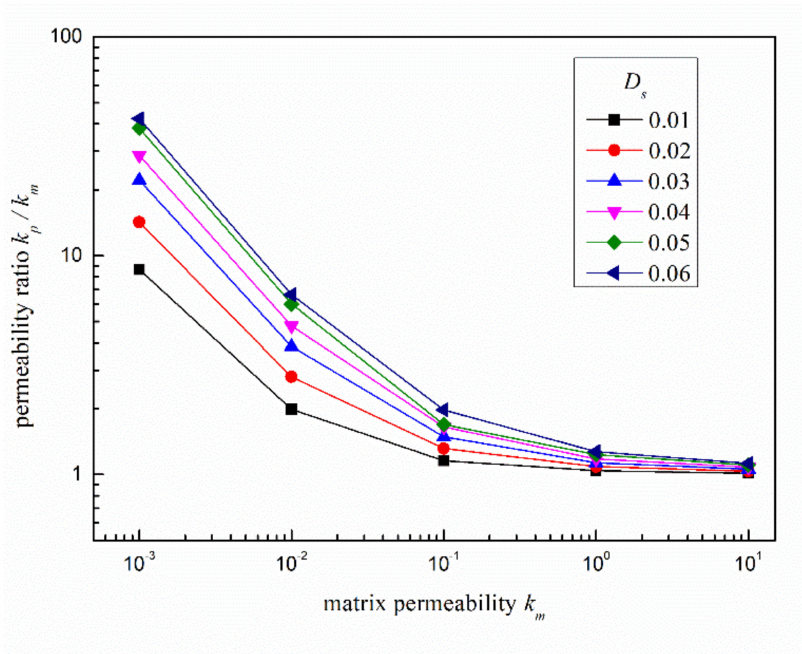
Figure 9. The effect of fracture on matrix with different